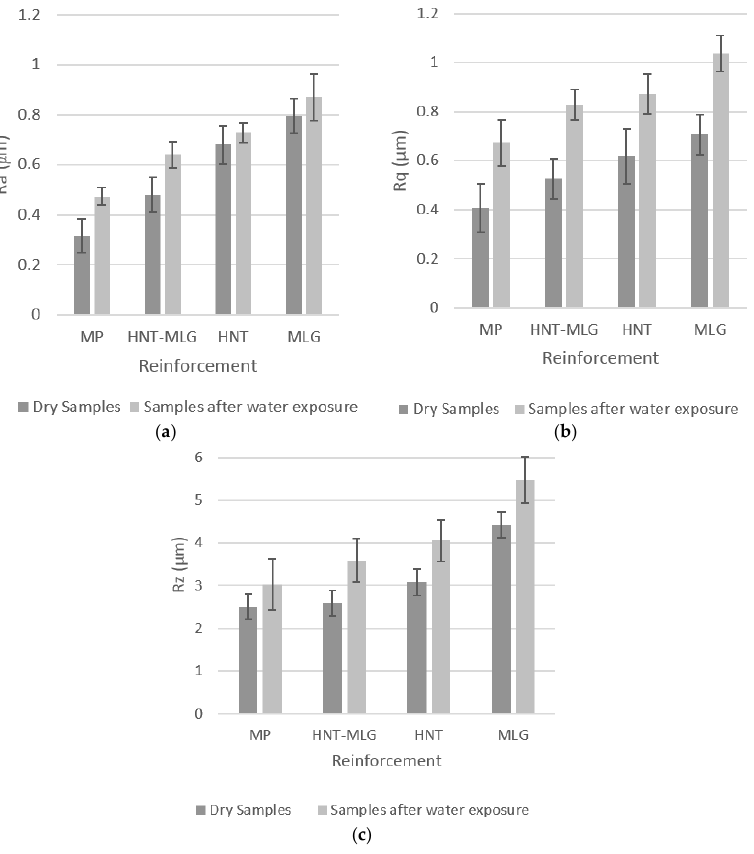
Figure 8. Topographic features of nanocomposites in dry conditions and after water exposure: ( a ) average of surface’s roughness, R a ( μ m); ( b ) root mean square of profile, R q ( μ m); ( c ) highest and lowest point of the profile, R z ( μ m)